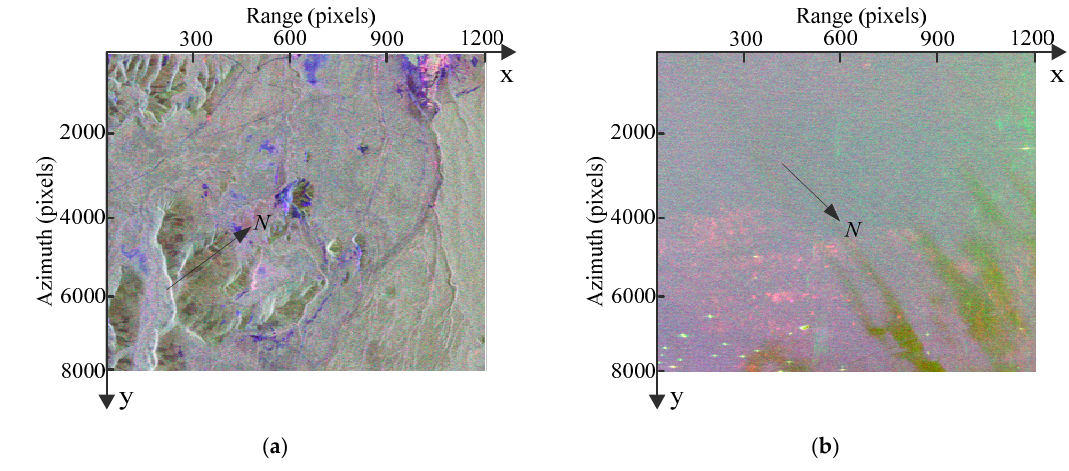
Figure 3. The PALSAR polarimetric images in two areas. ( a ) Changbai Mountain ( 42.17 N, 128.0 E) acquired on 3 December 2007 and ( b ) Qingdao ( 35.83 N, 120.75 E) acquired on 29 March 2011.